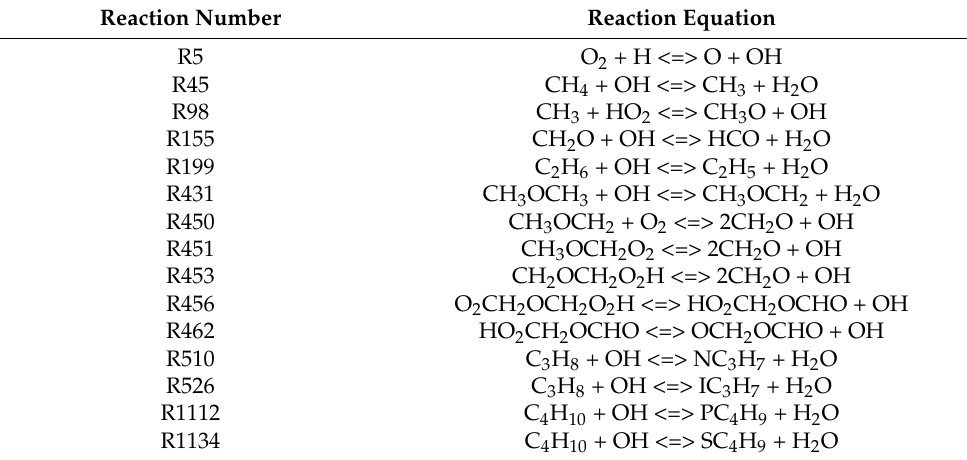
Table 2. Important elementary reactions involving OH radicals.